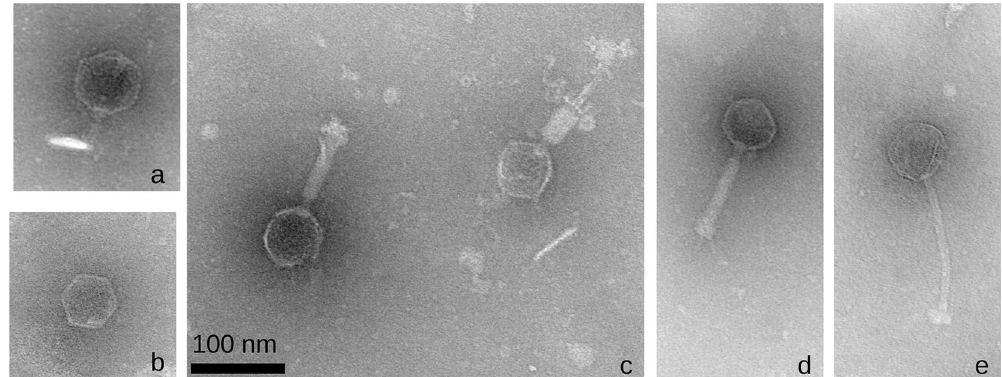
Figure 3. Transmission electron micrographs of the representative R. solanacearum phage species of five new genera with unique viruses (non described before): ( a ) Ralstonia phage Cimandef ( Cimandefvirus, Podoviridae ); ( b ) Ralstonia phage Anchaing ( Anchaingvirus, Autographiviridae ); ( c ) Ralstonia phage Raharianne ( Rahariannevirus, Myoviridae ); ( d ) Ralstonia phage Bakoly ( Bakolyvirus, Myoviridae ); ( e ) Ralstonia phage Dina ( Dinavirus, Siphoviridae ).